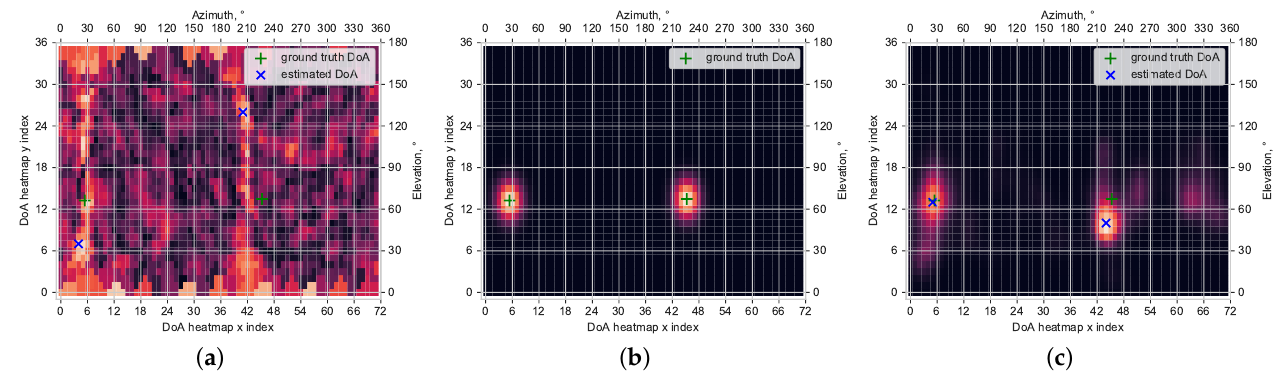
Figure 7. Examples of DoA heatmap output: ( a ) SRP-PHAT spatial power spectrum; ( b ) ground truth (used as a target for training of the CNN; Q θ = Q φ = 5°); ( c ) CNN estimated DoA heatmap ( Q θ = Q φ = 5°); same STFT input feature was used for both SRP-PHAT and our CNN